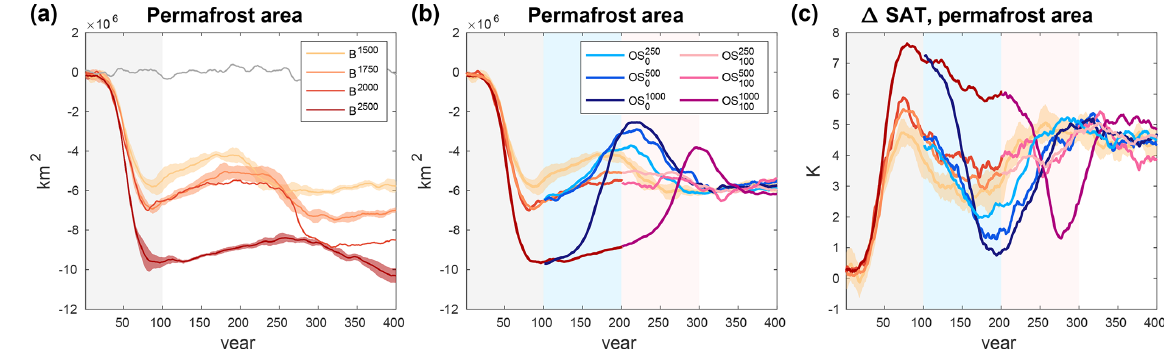
Figure 5. Change in permafrost area relative to the pre-industrial control simulation. For clarity, panel (a) shows the B simulations only with positive emissions for 100 years and zero emissions thereafter, while panel (b) show the overshoot simulations branched from the B simulations. Panel (c) shows the surface temperature anomalies over the area that is occupied by permafrost in the pre-industrial control simulation. The shaded areas in the background indicate the different phases of the simulations (grey: positive emissions; light blue: negative emissions for the short overshoots; light red: negative emissions for the long